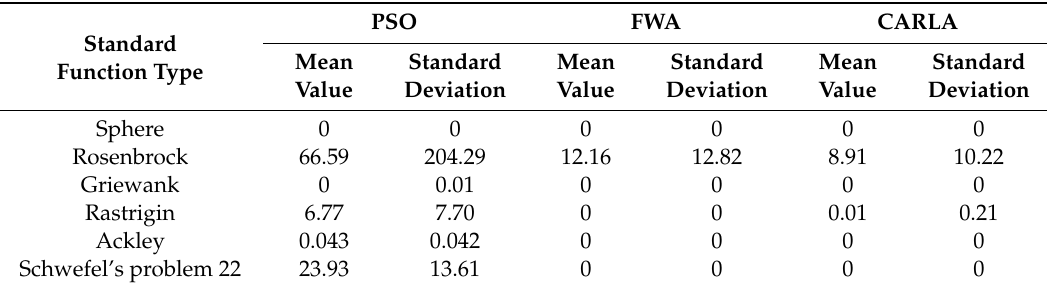
Table 2. Parameter configuration of the test function. PSO: particle swarm optimization.